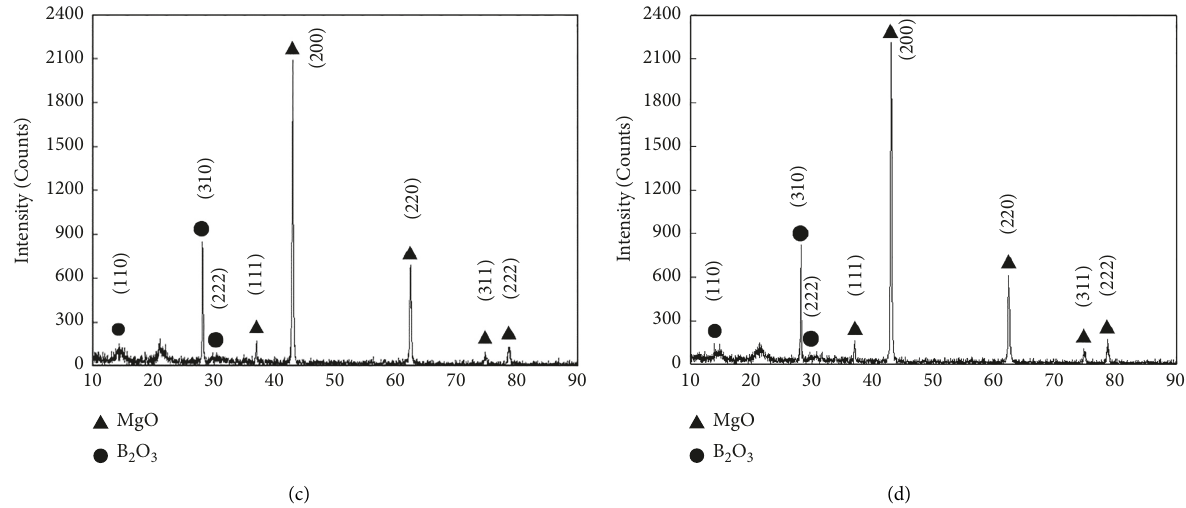
Figure 2: XRD composition analysis of coating A at different thickness: (a) 100 μ m, (b) 200 μ m, (c) 300 μ m, and (d) 500 μ